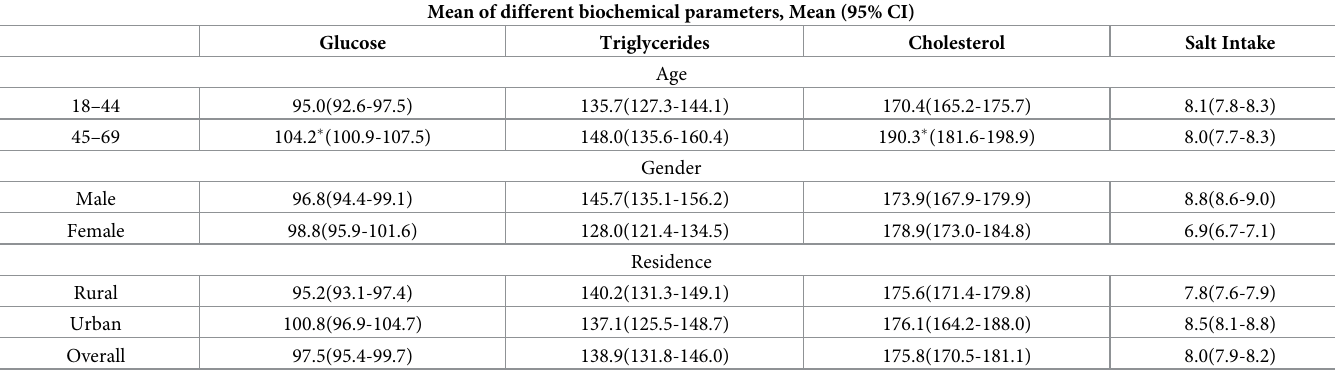
Table 4. Means (Confidence intervals) of different biochemical parameters in population of Haryana, 2016-2018.